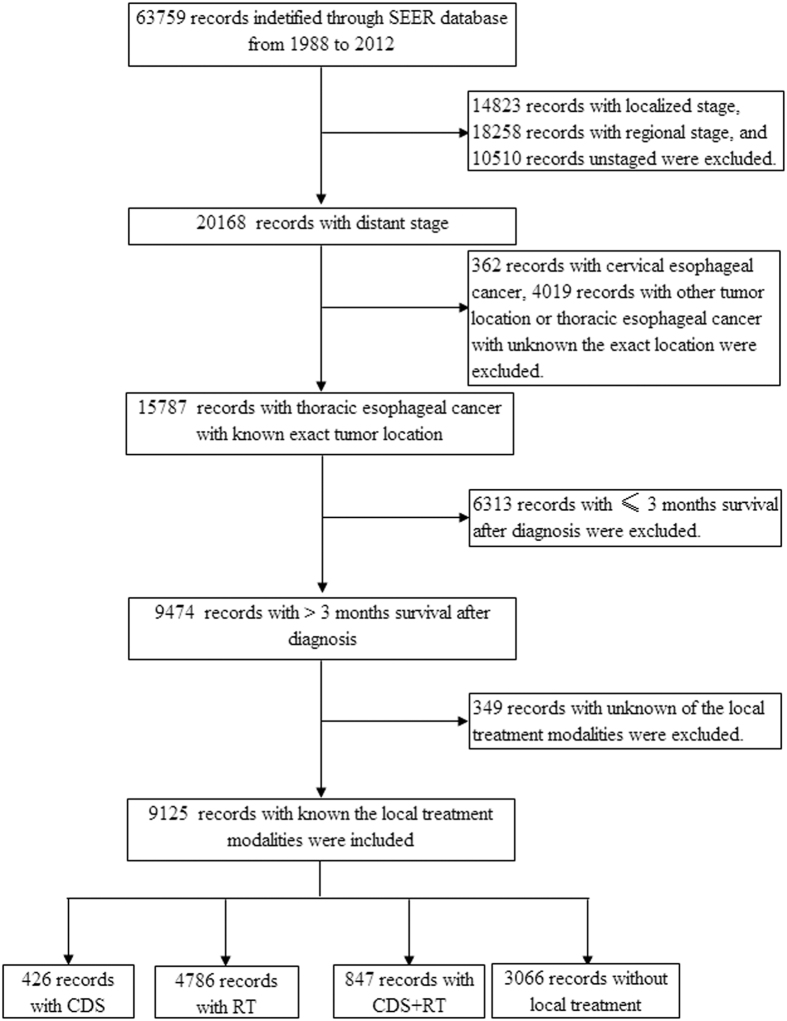
Patients included in analysis.